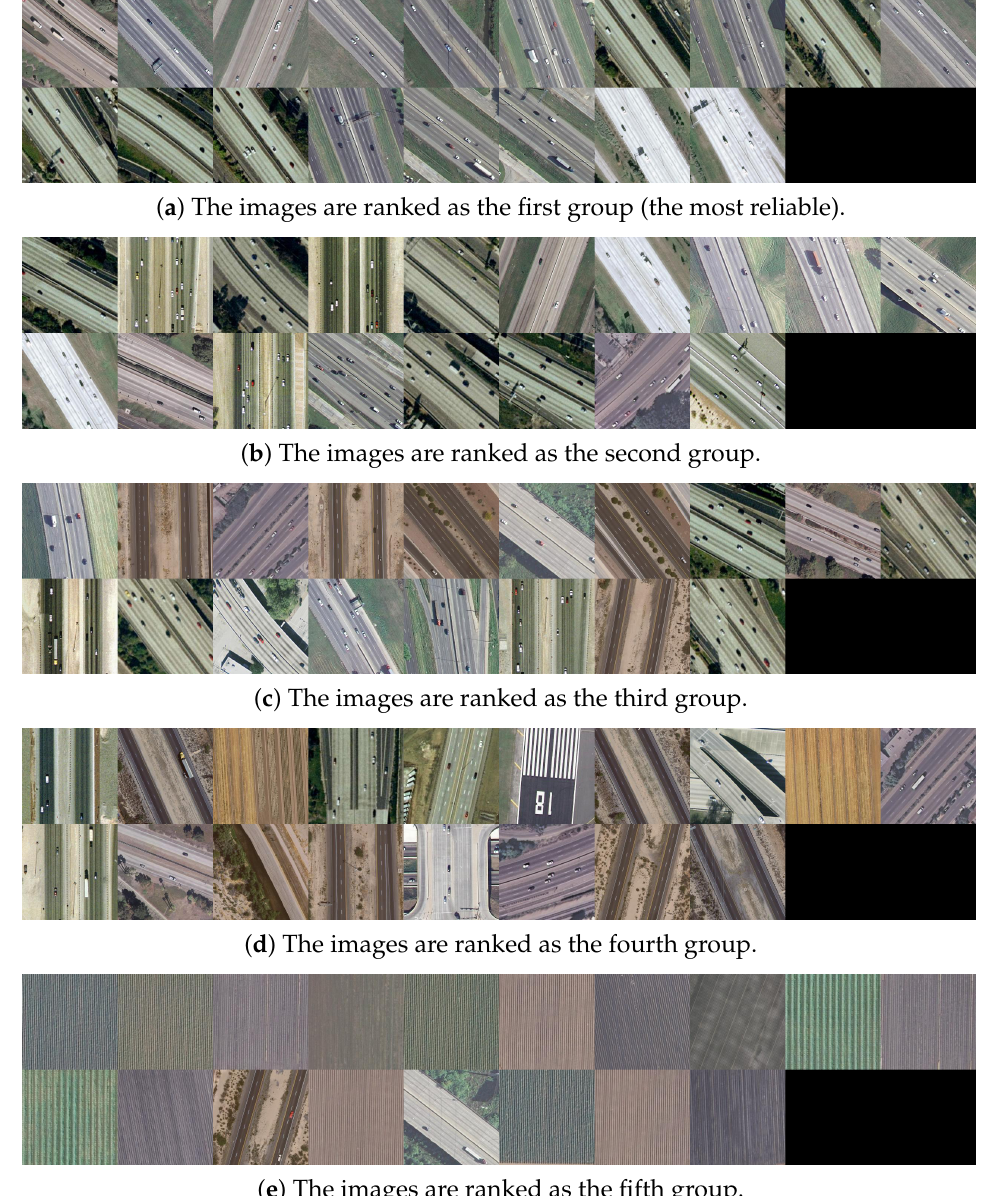
Figure A3. In the first, second, and third groups, all the images are correctly clustered. In the fourth group, there is 1 image of river and runway, 2 images of agricultural and overpass, and 12 images of freeway. In the last group, there are only 2 images of